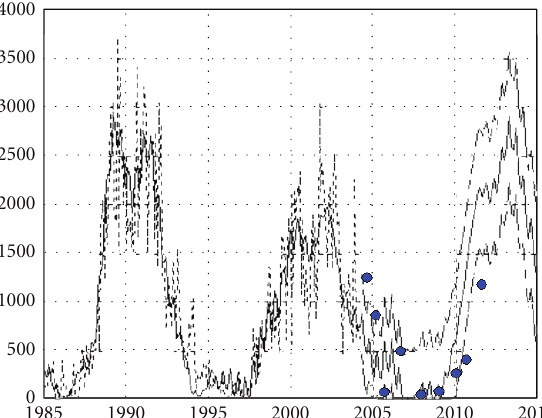
Figure 3: Model, prediction, and epignosis of the monthly mean sunspot areas pattern. Dotted line demonstrates the real data. Dashes show the one sigma intervals. Blue dots are principal epignosis control marks. Abscissa axis fix years of the last modeled and predicted intervals. Ordinate axis shows sunspot area values in units of millionths of a